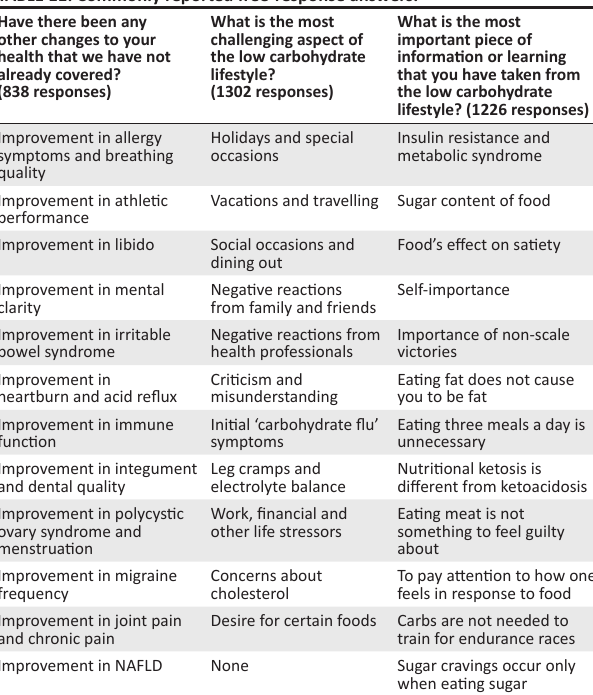
TABLE 11: Commonly reported free-response answers. Have there been any other changes to your health that we have not already